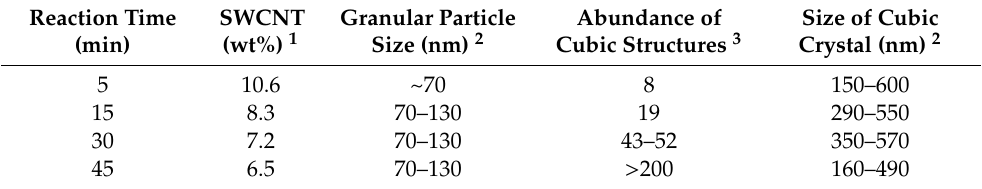
Table 2. Morphological composition of Cu-SWCNT composites prepared by electroless deposition as a function of reaction time.